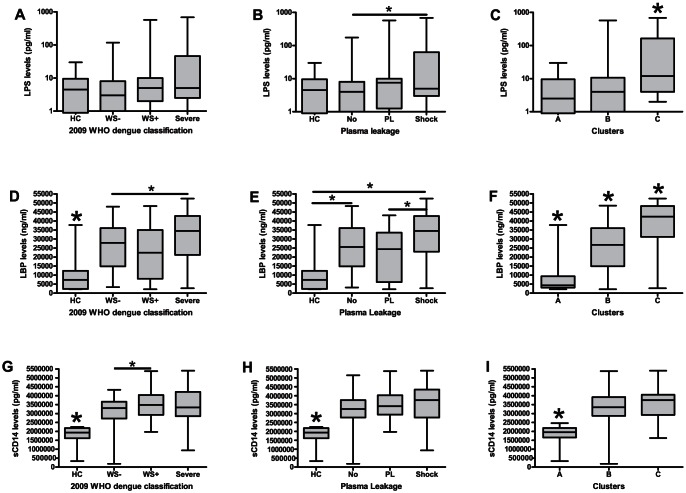
LPS, LBP and sCD14 levels in dengue virus infected patients.LPS: A: No significant differences in the 2009 WHO dengue case classification. B: Levels in patients with shock were significantly increased compared to patients without plasma leakage (P = 0,04). C: Cluster analysis: cluster C was significantly elevated compared to cluster A (P = 0,01), and B (P = 0,02). LBP: D: Levels were significantly elevated in all dengue patients compared to HC (WS− vs HC P = 0,009, WS+ vs HC P = 0,03, Severe vs HC P = 0,01). Levels in patients with severe dengue were significantly elevated compared to WS− dengue (P = 0,03). E: Levels were elevated in patients with shock (P = 0,008) and no plasma leakage (P = 0,008) compared to HC. Levels were also elevated in patients with shock compared to patients with plasma leakage (P = 0,03). F: In the cluster analysis levels in cluster C were significantly elevated compared to cluster A (P = 0,002) and B (P = 0,007). Moreover, cluster B was significantly elevated compared to cluster A (P<0,0001). sCD14: G: In the 2009 classification levels of sCD14 in DENV infected patients were significantly elevated compared to HC (WS−, WS+ and severe vs HC P<0,0001). Levels were significantly increased in WS+ compared to WS− patients (P = 0,04). H: In the plasma leakage/shock classification levels of sCD14 in DENV infected patients were significantly elevated compared to HC (No, PL and shock vs HC P<0,0001). I: In the cluster analysis cluster B (P<0,0001) and C (P = 0,002) were significantly elevated compared to cluster A. Abbreviations: HC : healthy control, WS−: non-severe dengue without warning signs. WS+: non-severe dengue with warning signs, No : No occurrence of plasma leakage, PL: occurrence of plasma leakage. Horizontal bars inside the boxplot indicate the median. The box indicates the interquartile range. Black asterisk = significantly different from all other groups. Underlined black asterisk = significant difference between two groups. The Mann-Whitney U test was used to compare the groups with each other.